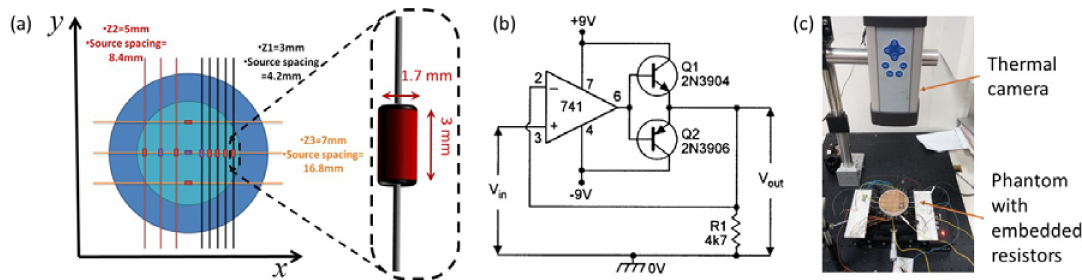
Figure 3. Phantom set-up. ( a ) Sets of resistors embedded in gels with different distances between them horizontally and 3 different depths. The resistors marked with purple are the ones which a thermal couple was embedded with them and was used to verify the actual temperature. All resistors are identical in their thermal and electrical properties. Multiple function generators supply current to the resistors thus creating different controllable temperatures and frequencies; ( b ) An electrical diagram showing the design of the Bidirectional current booster circuit that was used to amplify the function generator’s signal and supply the proper current o the resistors; ( c ) A photo of the actual phantom and thermal camera positioned to capture the entire phantom.